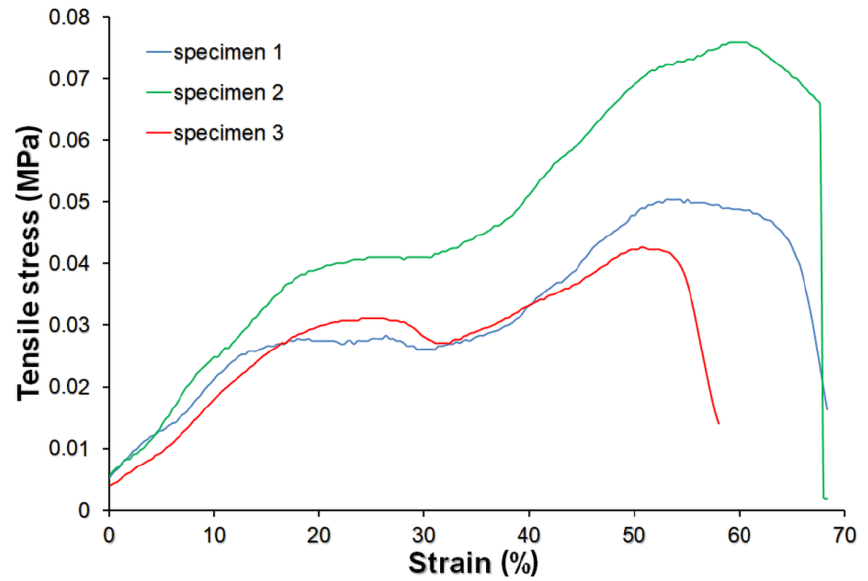
Figure 4. Tensile stress-strain curves obtained for three independent specimens of chitosan/agarose biomaterial.